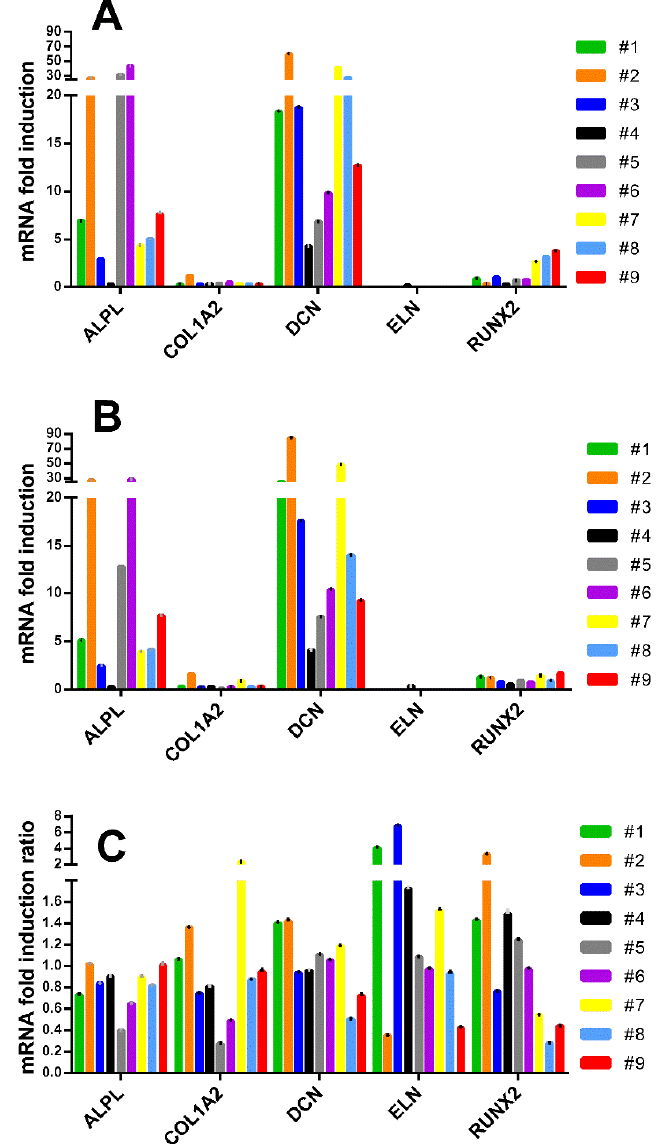
Figure 6. Inter-donor heterogeneity for fold increase in osteogenic signature gene induction against corresponding non-induced hMSC derived from donors #1–#9 detected by the TaqMan™ method measured at ( A ) 1 week and ( B ) 2 weeks. ( C ) Close parity for gene induction at the 1- and 2-week time points resulted in most gene induction ratios being close to one. Interpolation used GUSB/YWAHZ reference genes. Inter-assay variability is shown by error bars indicating the pooled coe ffi cient of